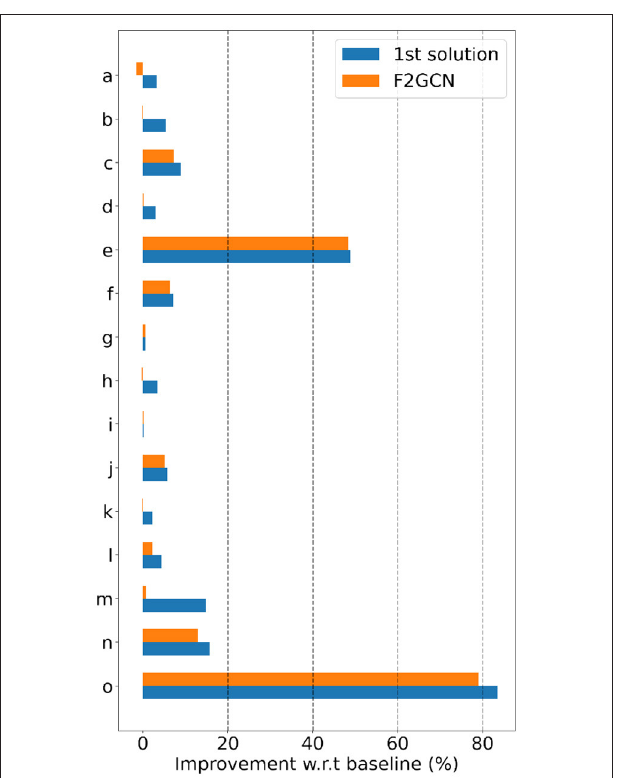
FIGURE 2 | Accuracy improvement with respect to